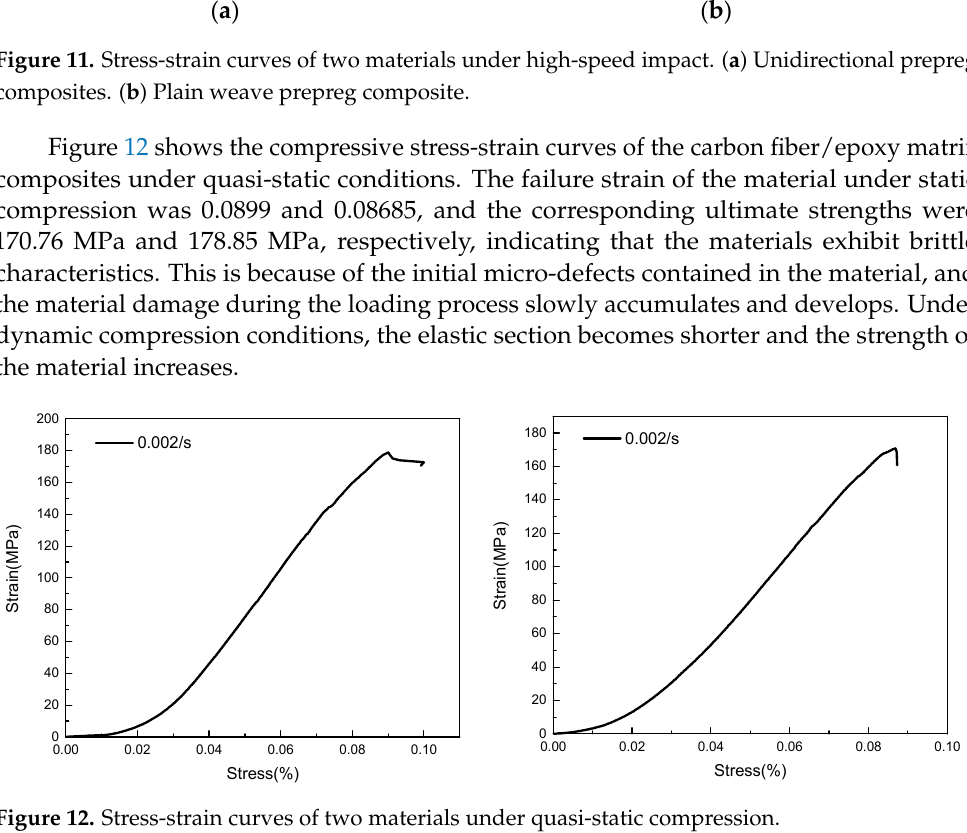
Figure 12. Stress-strain curves of two materials under quasi-static compression.